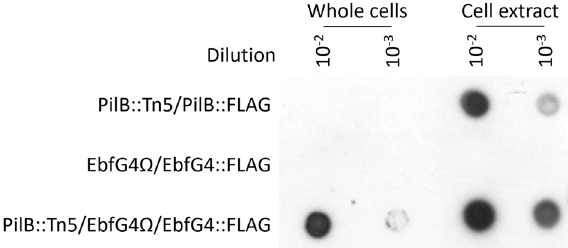
Fig. 3 Dot-blot analysis using anti-FLAG antibodies. Whole cells and cell extracts of the following strains were analyzed: pilB - inactivated strain complemented with FLAG-tagged PilB (PilB::Tn5/ PilB::FLAG), ebfG4 -inactivated strain complemented with FLAG- tagged EbfG4 (EbfG4 Ω /EbfG4::FLAG) and the latter strain that also harbors pilB inactivation (PilB::Tn5/EbfG4 Ω /EbfG4::FLAG). Strains PilB::Tn5/PilB::FLAG and EbfG4 Ω /EbfG4::FLAG are planktonic and PilB::Tn5/EbfG4 Ω /EbfG4::FLAG forms bio fi lm. All data are derived from the same experiment and they were processed in parallel (see unprocessed image in supplementary